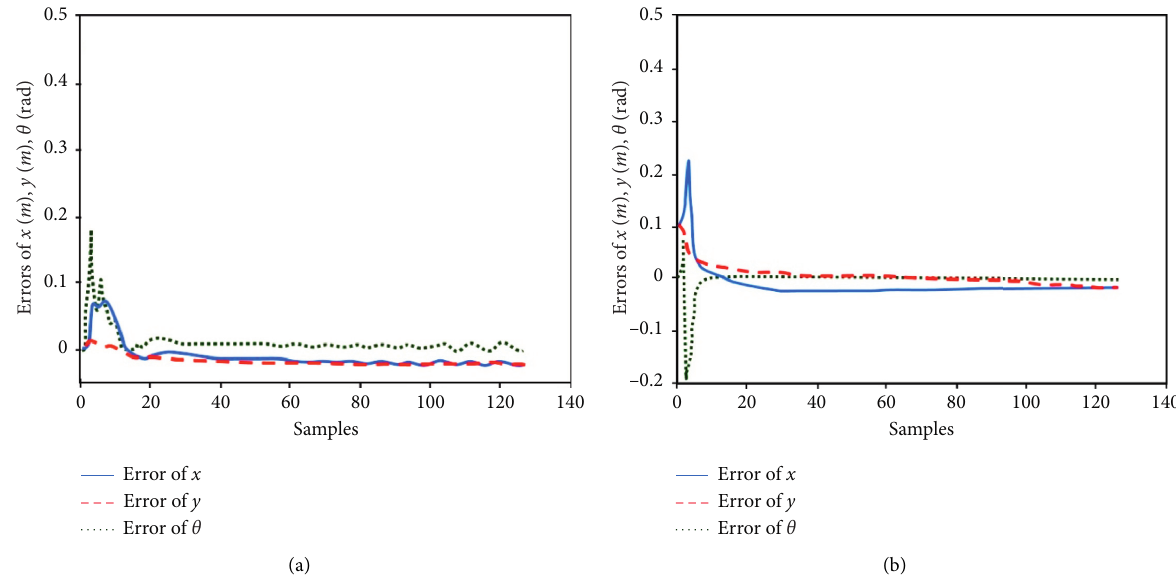
Figure 9: The error of x and y coordinates and orientation θ of DDMR in orbicular trajectory with (a) NNFOPID controller and (b) NNPID